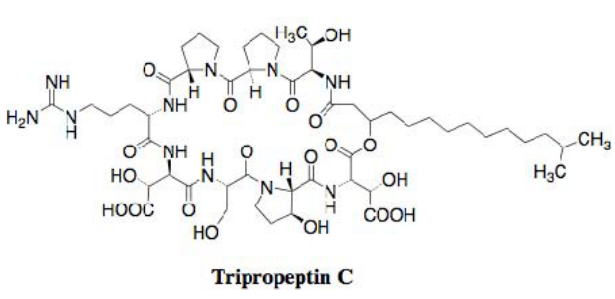
Figure 3. Structure of tripropeptin